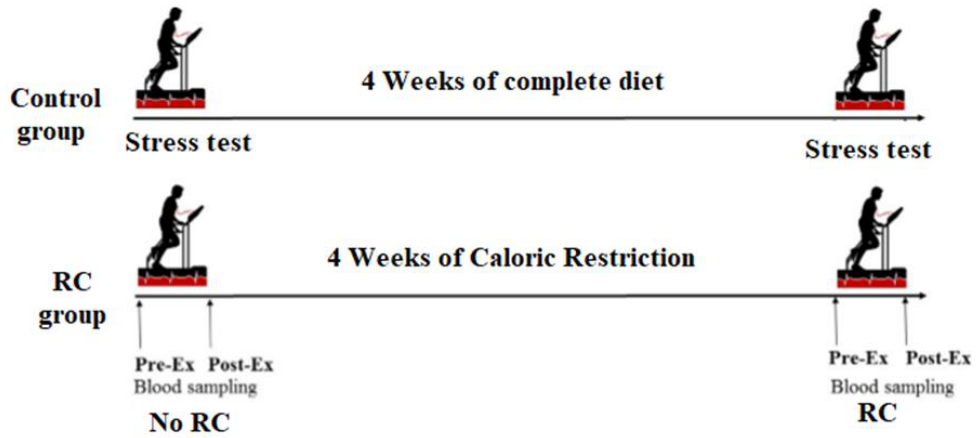
Figure 1. Diagram of the treatment time line. RC—restricted calorie.